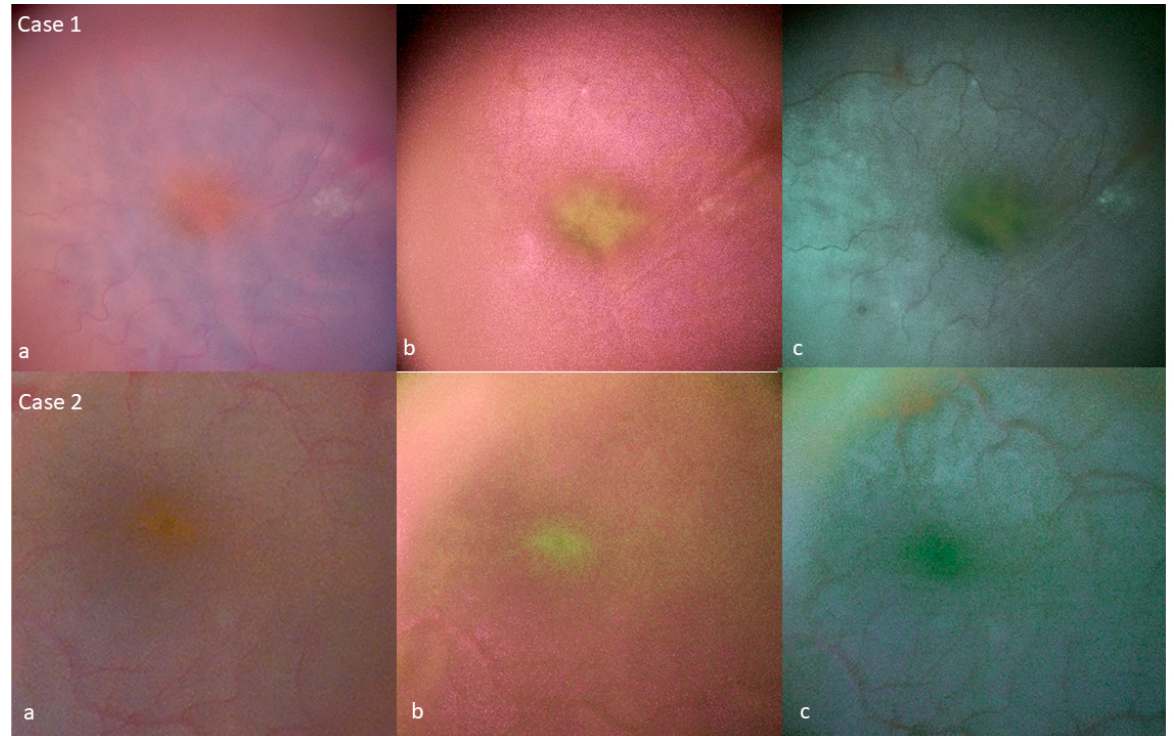
Figure 1. Enhancement of the visualization of MP at the end of surgery for epiretinal membrane surgery. In two different cases ( a ) Standard color, ( b ) filter 1, ( c ) filter